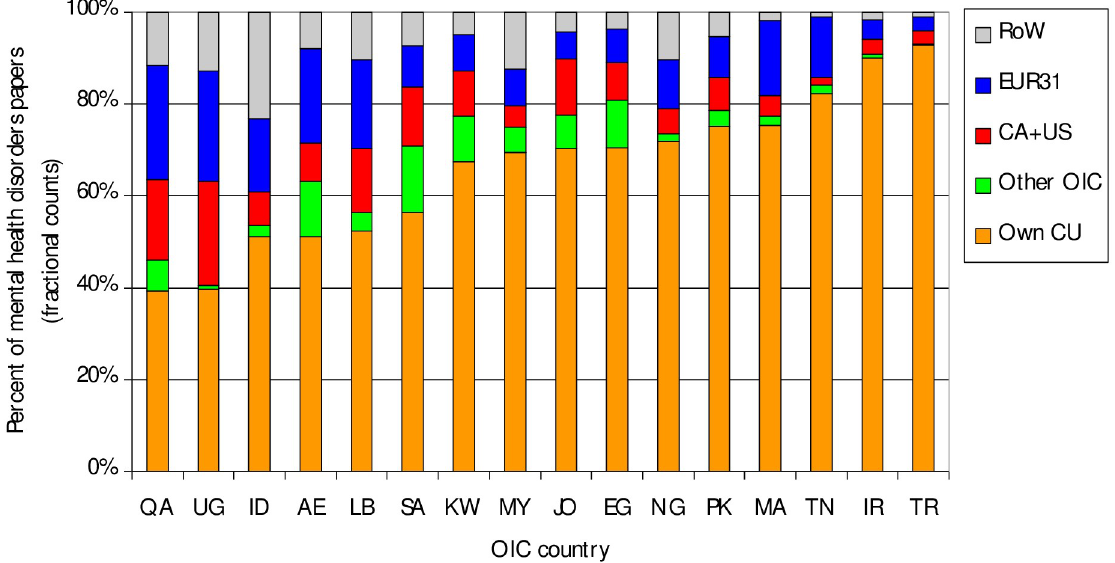
Fig 3. Collaboration in OIC mental disorders research with others in the OIC, Canada + USA, EUR31, and the Rest of the World (RoW).